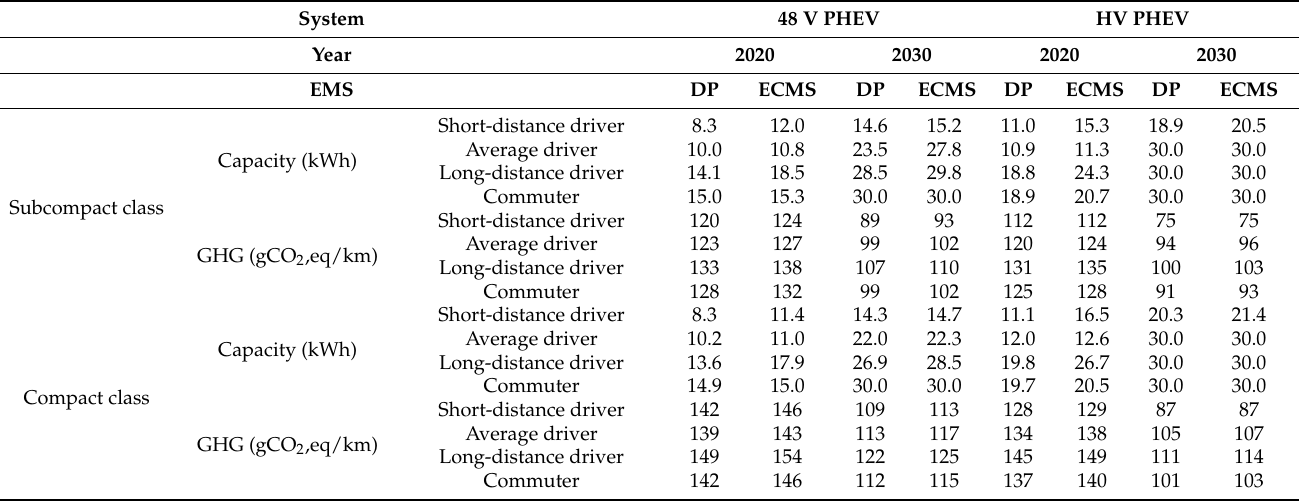
Table 5. Derived optimal battery capacities and resulting life cycle GHG